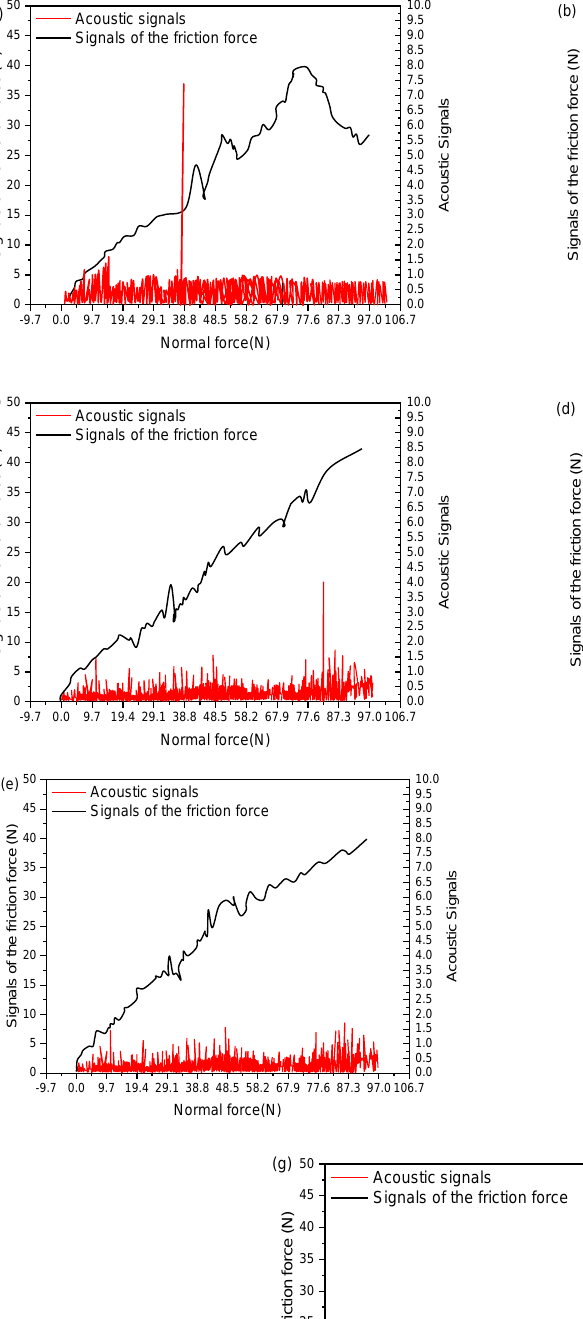
Figure 5. T he bonding strength of different B 4 C /Ni63 coatings.